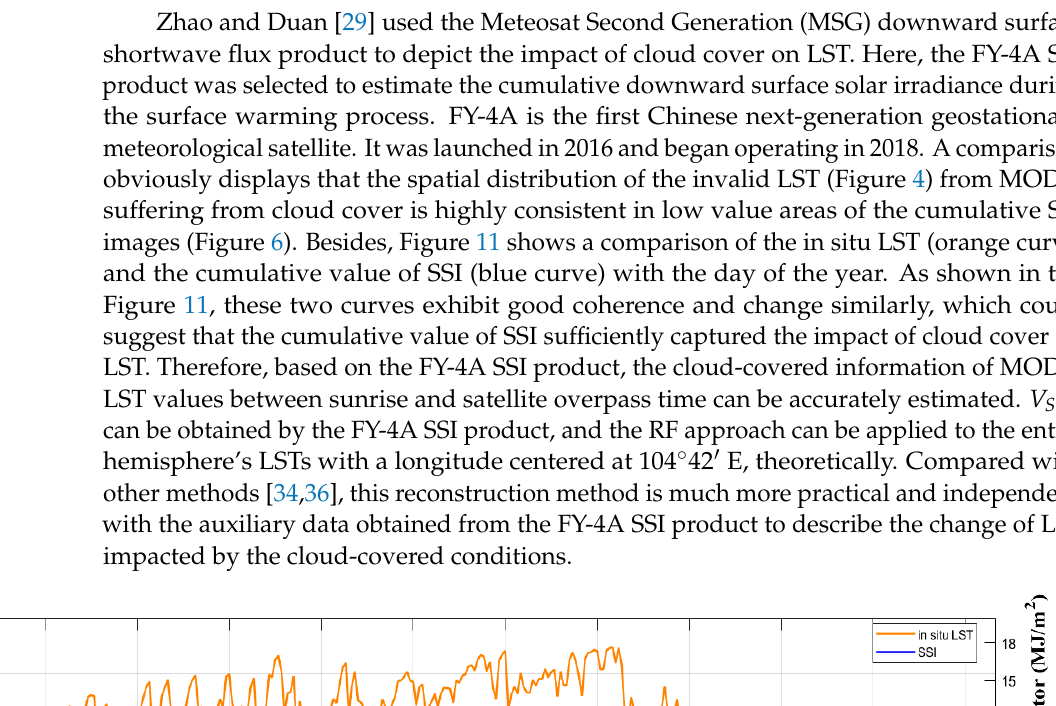
Figure 12. ASTER LST images over the sites: ( a – c ) acquired on 14 August 2018 and ( d ) acquired on 2 January 2018.